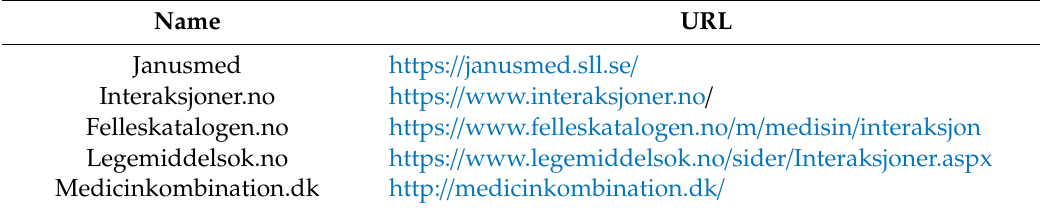
Table 5. The drug interaction checkers sampled for the study.